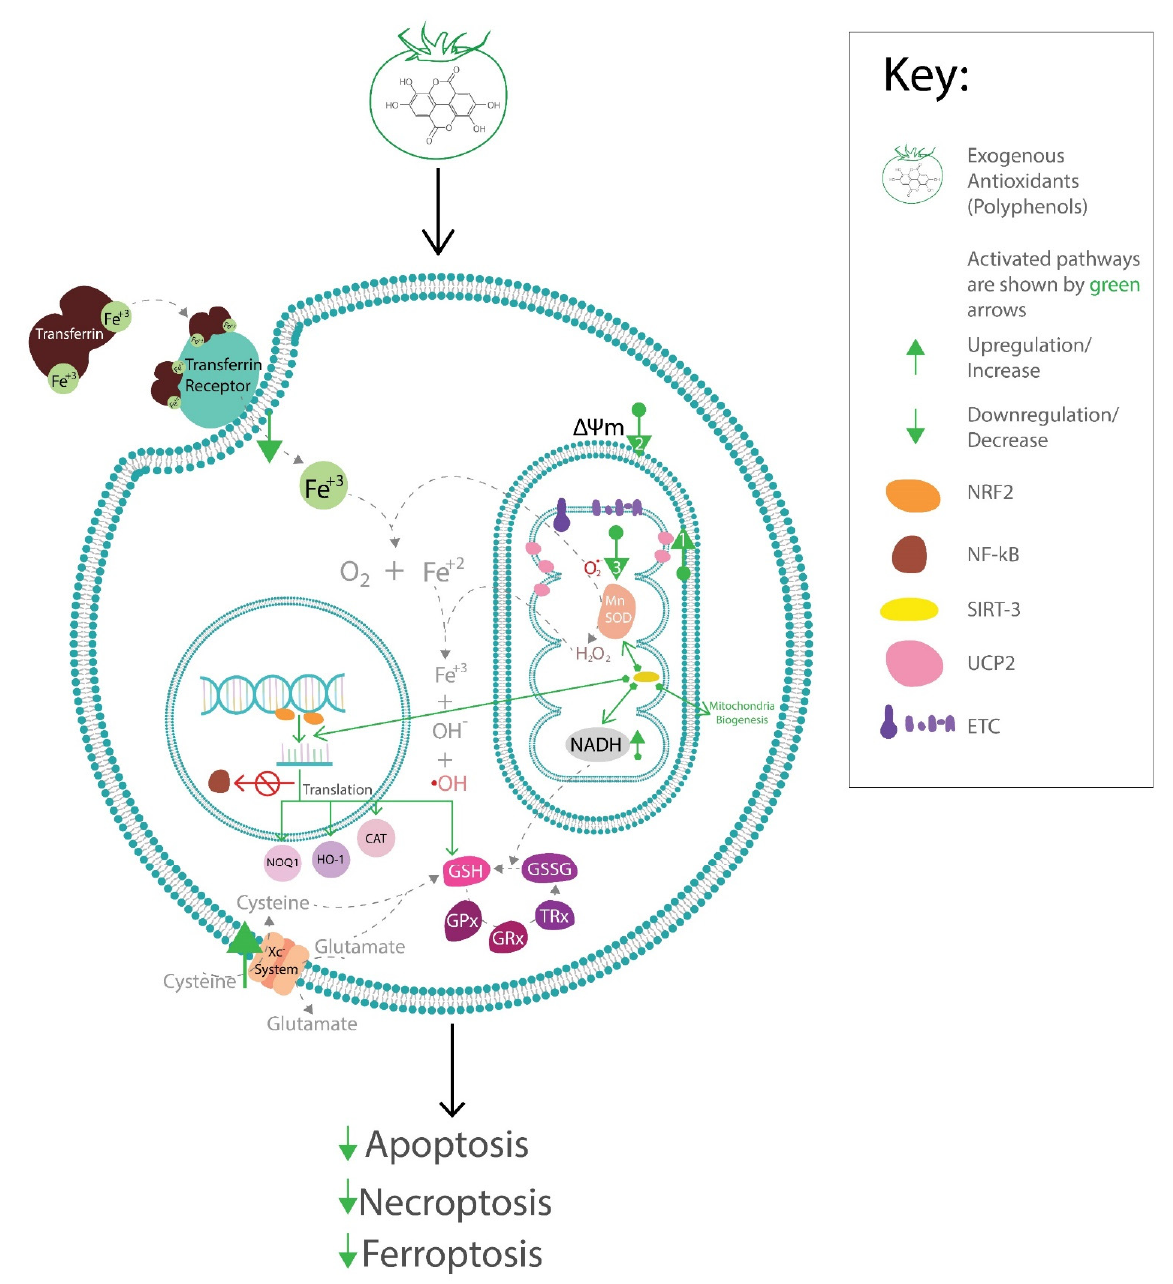
Figure 2. Summary of the effects of polyphenols on endogenous antioxidant systems. In hyperglycemia-induced oxidative stress, polyphenols increase UCP expression (1), reduces mitochondria membrane potential ∆Ψ m (2) which leads to reduction in O 2 − (3); preventing mitochondrial damage and apoptosis/necroptosis. Polyphenols enhance Gpx/GSH/Trx function by increase in synthesis of GSH via increased activity of Xc − transporter system, reduction in intracellular transport of Fe 2+ . Moreover, there is an increase in deacetylation activity of SIRT 3 which increases activity of isocitrate dehydrogenase activity (not shown) [189] and NADH leading to regeneration of GSH. Both the latter and former prevent ferroptosis. Polyphenols also enhance SOD activity via SIRT1/3-dependent mechanisms. Finally, increased SIRT3 activity also increases translation of several antioxidant enzymes including NOQ1, HO-1, and CAT via Nrf2-dependent mechanisms. Activation of Nrf2 inhibits NF-kB transcription activity, thereby preventing oxidative stress-induced inflammation which is associated with insulin resistance and endothelial